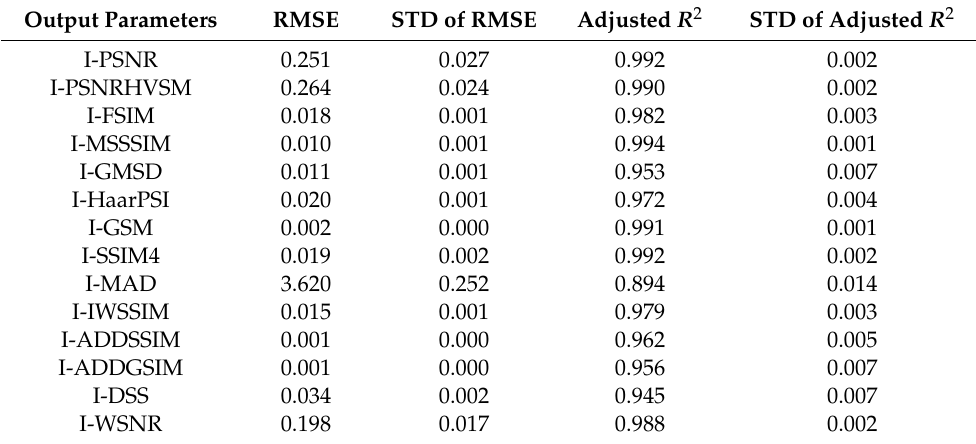
Table 4. Self-dataset validation in the same channel (#